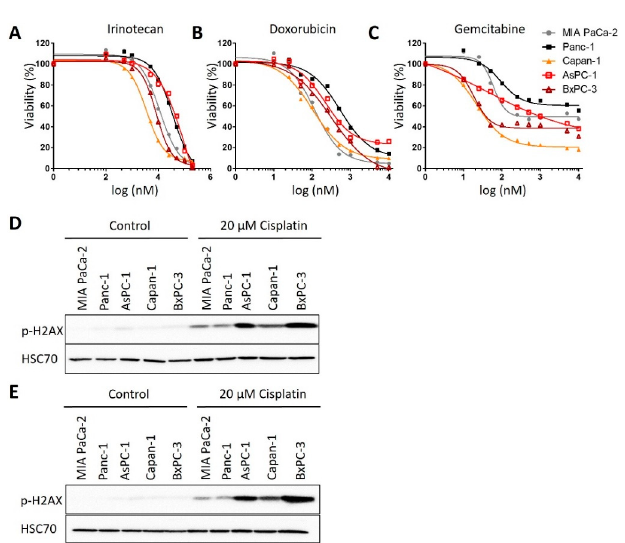
Figure A1. Chemosensitivity of PDAC cells. ( A – C ) Treatment of the PDAC cell panel with ( A ) 0.25 µM to 30 µM irinotecan, ( B ) 0.1 µM to 200 µM doxorubicin, and ( C ) 10 nM to 10 µM gemcitabine for 72 h. Viability of cells was measured by an ATP-based luminescence assay. ( D , E ) Immunoblot analysis of the DNA damage marker phospho-H2AX after treatment with 20 µM cisplatin for 24 h. HSP70, loading control. Replicate experiments for Figure 1C. The blots were used for quantification, cf. Figure 1D.